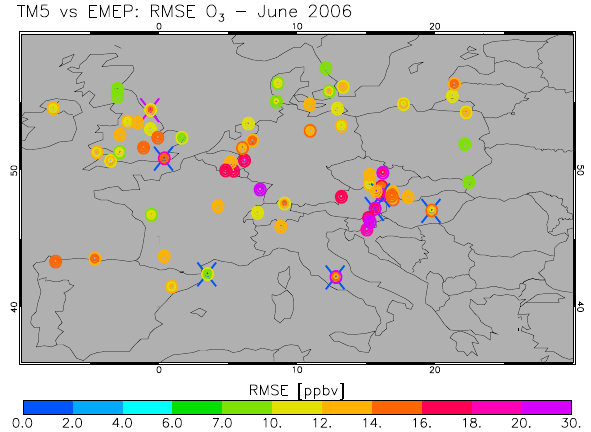
Fig. B2. Root mean square error (RMSE) of modeled surface ozone against hourly EMEP station data at stations below 800m altitude. Outer circles: 3 ◦ × 2 ◦ run, middle circles: 1 ◦ × 1 ◦ , inner circles: 0 . 5 ◦ × 0 . 25 ◦ . Blue crosses denote locations where an increase in resolution leads to a consistent reduction in RMSE with more than 2ppbv for both zoom runs, compared to the 3 ◦ × 2 ◦ run. Purple crosses denote a similar consistent increase in